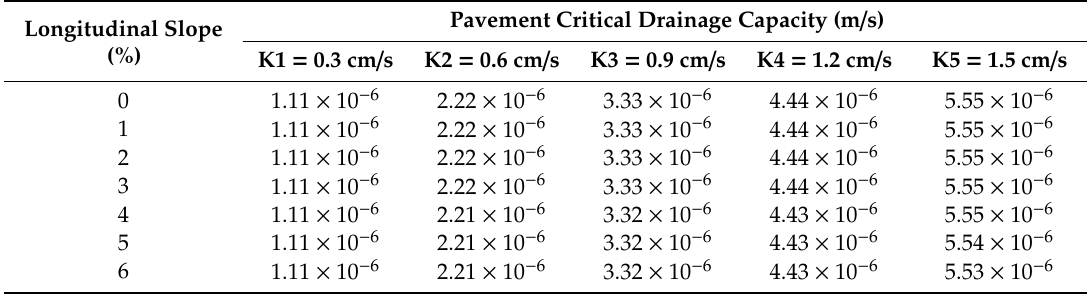
Table 9. Calculation result of the critical drainage capacity of pavement with di ff erent transverse slope of 1% for the second boundary condition.